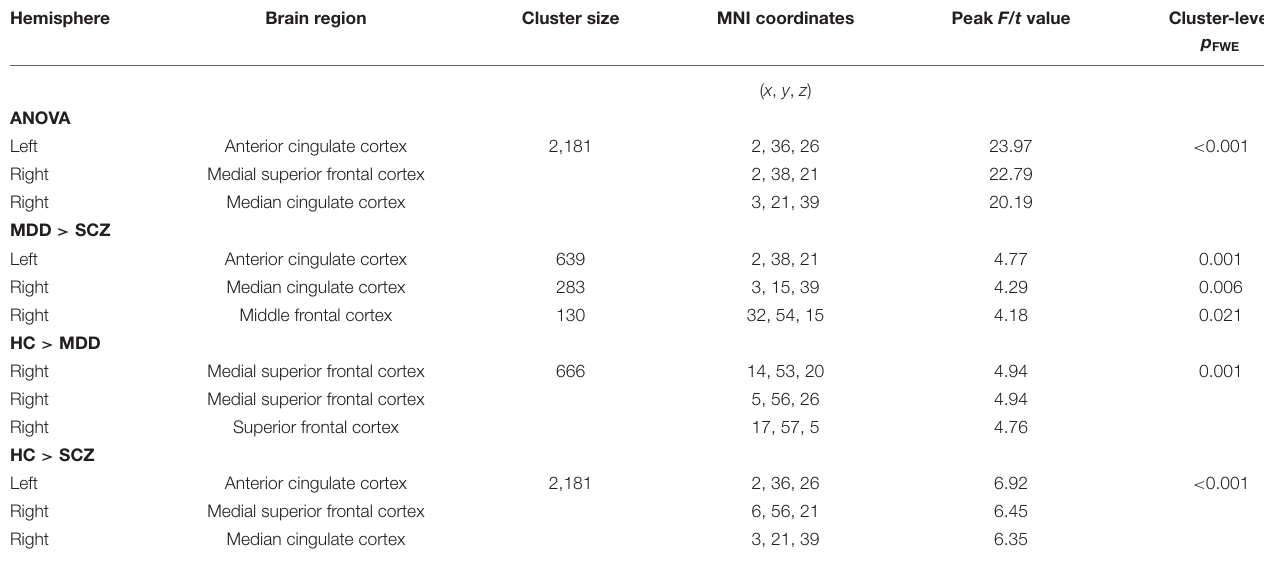
TABLE 2 | Results of GMV analysis of the patients with schizophrenia patients, major depressive disorder patients and healthy controls (controlling for age, gender, education, and total volume of the whole brain, p < 0.05, cluster-level whole-brain FWE corrected).